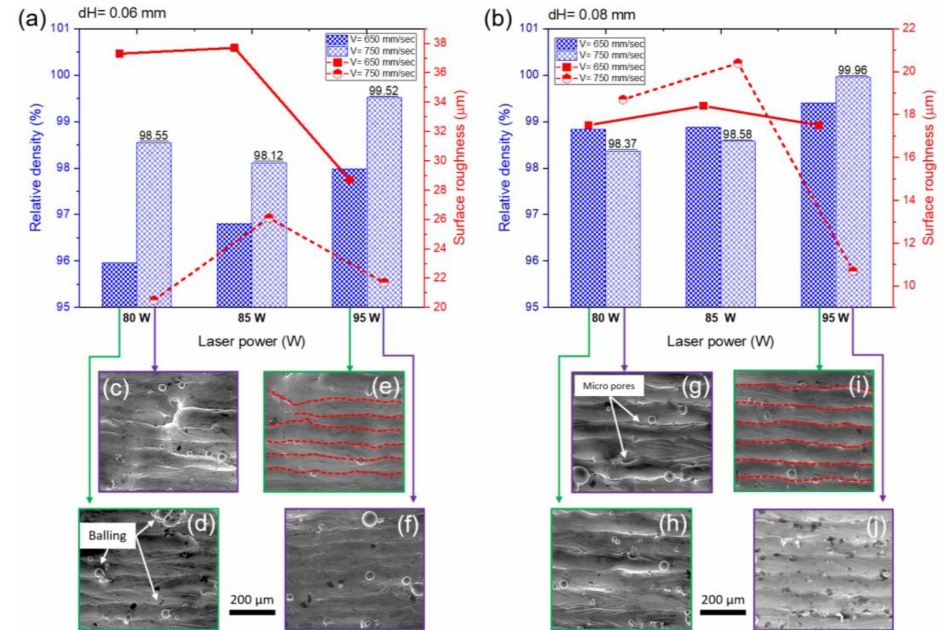
Figure 6. ( a , b ) Relative density and surface roughness of Inc718 samples produced by micro-LPBF; full factorial design with laser power of 80 W, 85 W, and 95 W, scanning speed of 650 mm/s, and 750 mm/s, hatch distance of 0.06 mm, and 0.08 mm; ( c – j ) surface topography of 12 samples from full factorial design showing surface defects such as porosity and